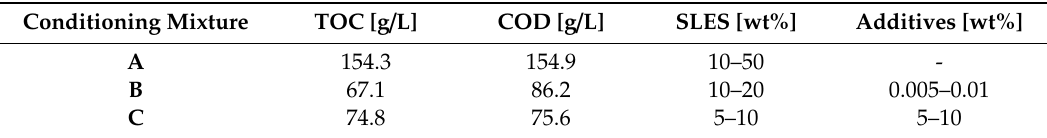
Table 1. Characteristics of the conditioning mixtures used in the